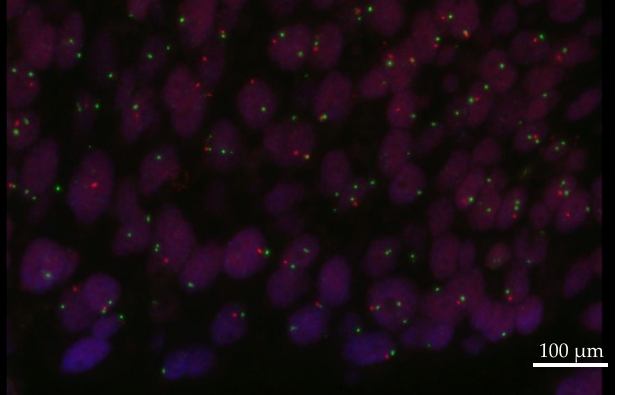
Figure 4. FISH image of heterozygous loss of PTEN. The red signal represents PTEN (chromosome location 10q23), and the green signal represents centromere 10. In the case of a heterozygous deletion, one red signal (10q23) is accompanied by two green signals in the nucleus. (Image by kind courtesy of Prof. Dr. Müllauer). Scale bar = 100 µ